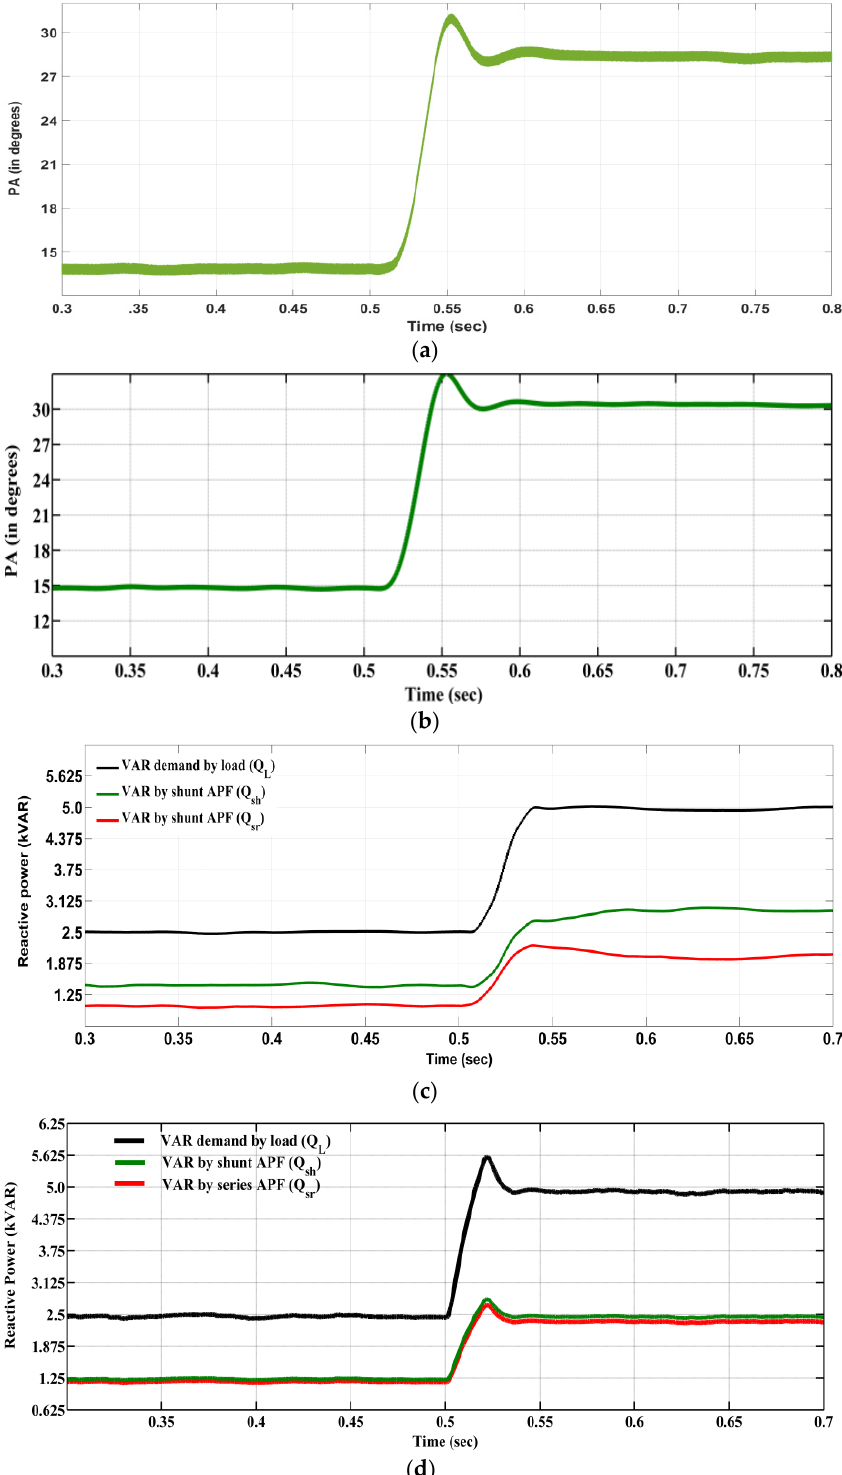
Figure 12. Comparative performance analysis between PQ and SRF methods: ( a ) PA estimation by PQ method; ( b ) PA estimation by SRF method; ( c ) reactive power share by PQ method; ( d ) reactive power share by SRF method. Table 3. Comparative analysis between PQ and SRF methods for PA estimation.